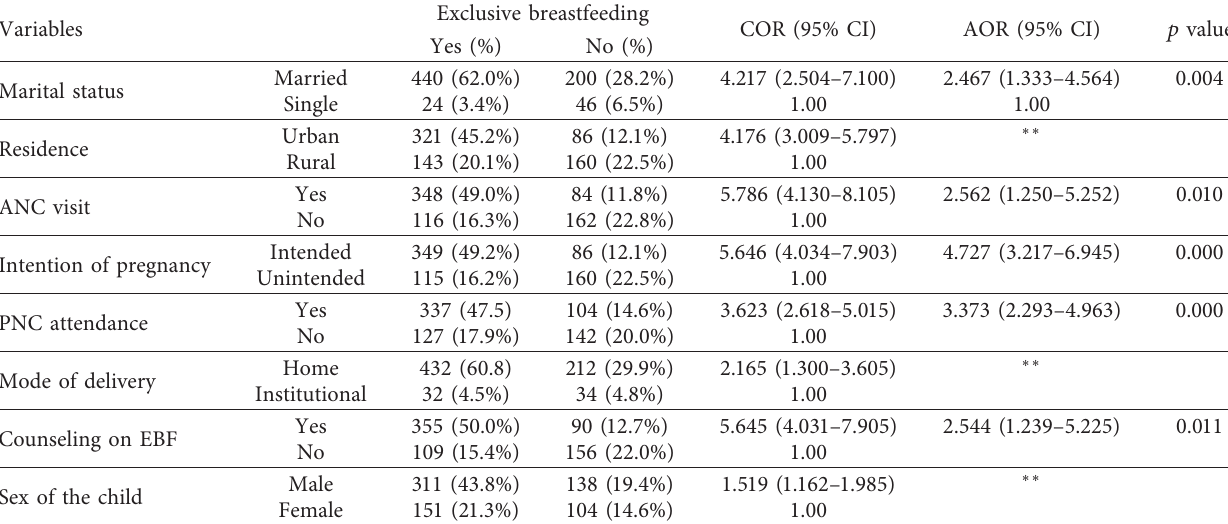
Table 4: Bivariate and multivariate regression analysis of factors associated with exclusive breastfeeding among women in west Shoa zone.